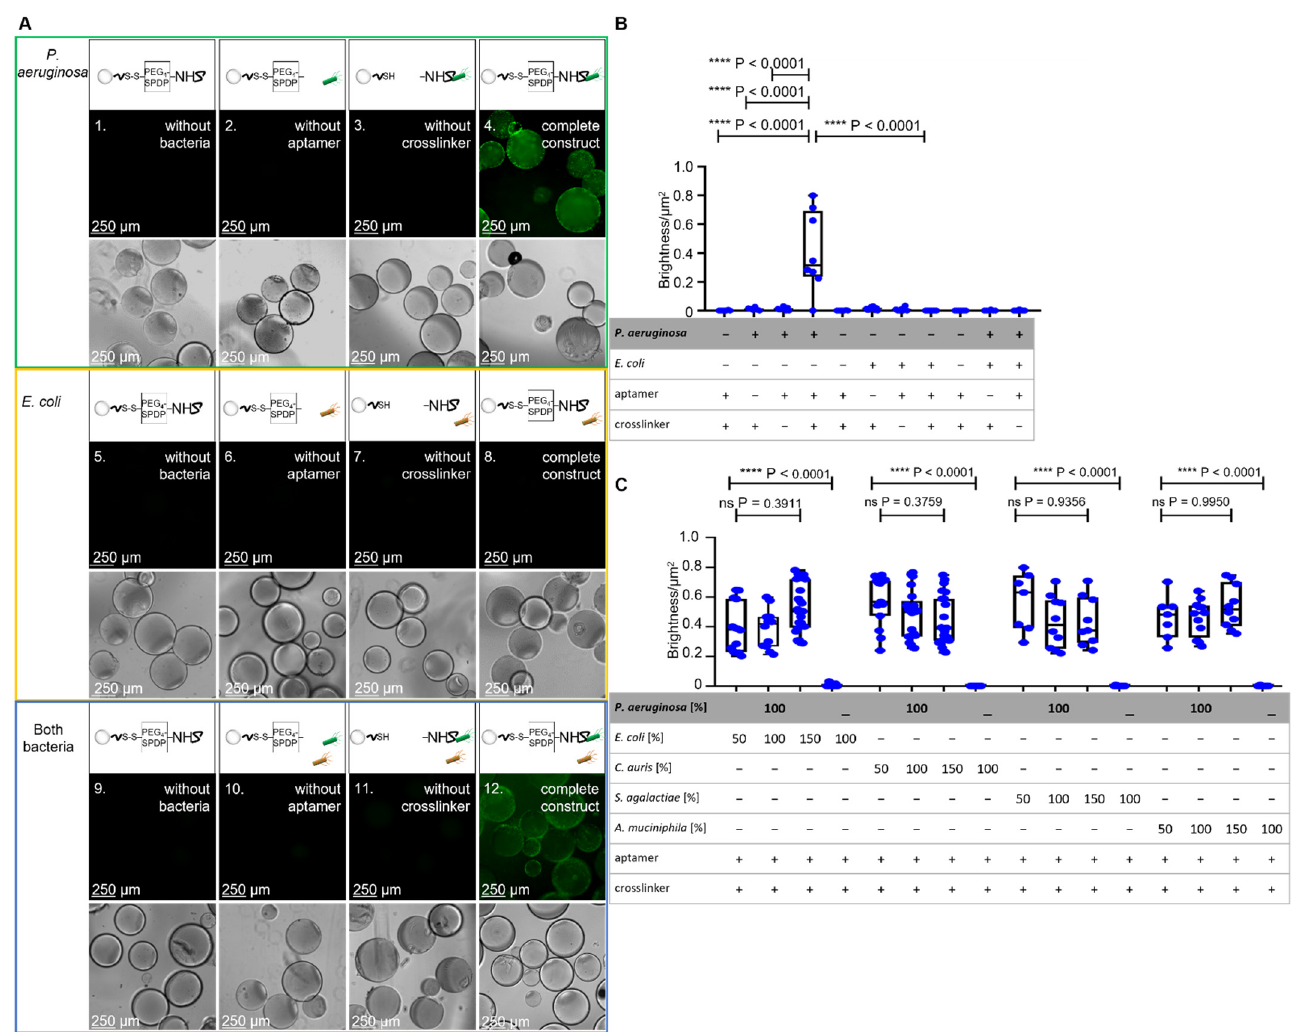
Figure 3. Analysis of incompletely and fully functionalized ACB constructs with PEG 4 -SPDP- and NH 2 -labeled aptamer. ( A ) Fluorescence microscopy and phase-contrast microscopy of the fully functionalized ACB constructs with GFP-modified P. aeruginosa and E. coli cells in comparison to incompletely functionalized constructs under fluorescence microscopy at 100× magnification. ( B ) BSF analysis of the different functionalized constructs with P. aeruginosa and E. coli . The statistical comparison of an unpaired t-test with Welch’s correction shows significant p -values of p < 0.0001 between the full constructs with P. aeruginosa and incompletely or fully functionalized constructs with E. coli . ( C ) BSF analysis of fully functionalized ACB constructs with different ratios of non-binding bacteria, including E. coli , Candida auris , Streptococcus agalactiae , and Akkermansia muciniphila . The statistical analysis with a Brown–Forsythe ANOVA shows no significant (ns) p -values over all P. aeruginosa -including compositions. The complete ACB constructs without P. aeruginosa show signifi- cant p -values of p < 0.0001. The specificity experiments of Figure 3C were based on the P. aeruginosa target cells in mixtures with different ratios of non-binding bacteria. In order to determine the bind- ing of P. aeruginosa to ACB, in this set of experiments an amount of GFP-labeled P. aeru- ginosa cells (12,500 cells/250 µL, (100%)) was used in the presence of the different cell counts of “contaminating” microbes (6250 cells/250 µL, (50%)), (12,500 cells/250 µL, (100%)) and (18,750 cells/250 µL, (150%)), although sepsis with multiple pathogens is truly not common. For the non-binding “contaminating” bacteria the pathogenic yeast Candida auris, the gram-positive Streptococcus agalactiae and the gram-negative human gut bacte- rium Akkermansia muciniphila as control pathogens were used. The fluorescence analyses with BSFA showed as expected, non-reduced fluorescent halos of the bound P. aeruginosa and no significant differences at all mixtures with P. aeruginosa and the control pathogens